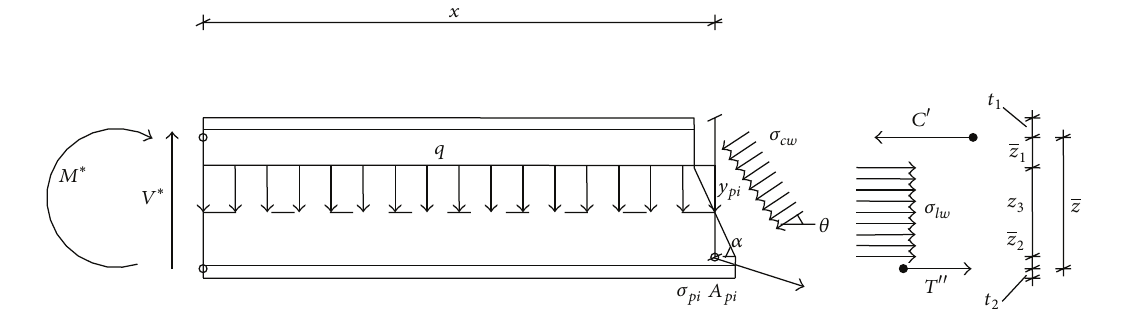
Figure 2: Beam segment with a cut parallel to the